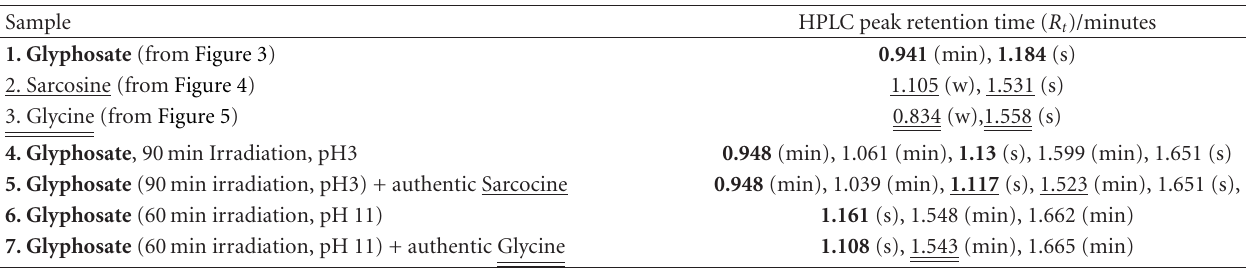
Table 2: Table showing HPLC peaks retention times, R t , for glyphosate, sarcosine, glycine (sample rows 1–3, resp.), irradiated mixtures of glyphosate at pH 3 and pH 11 (sample rows 4 and 6, resp.), and irradiated mixtures of glyphosate at pH 3 and pH 11 with authentic samples of sarcosine and glycine (sample rows 5 and 7, resp.). Peaks associated with glyphosate, sarcosine, and glycine are shown as bold , underlined, and double underlined text, respectively.